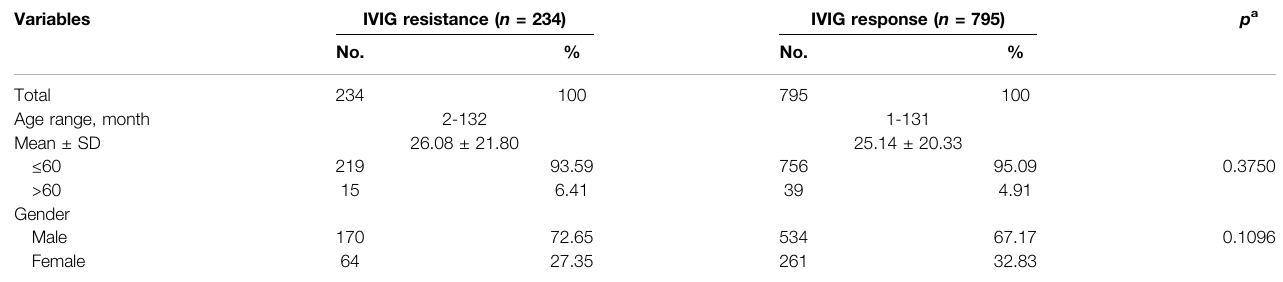
TABLE 1 | Characteristic distribution in the IVIG therapy resistant group and the response group of KD patients. Variables IVIG resistance ( n = 234)